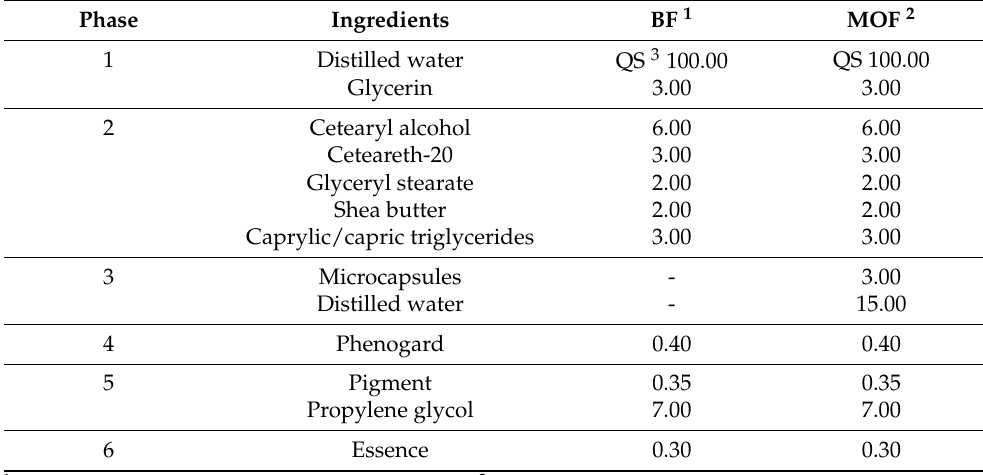
Table 1. Ingredients of cosmeceutical formulations (%; w / w